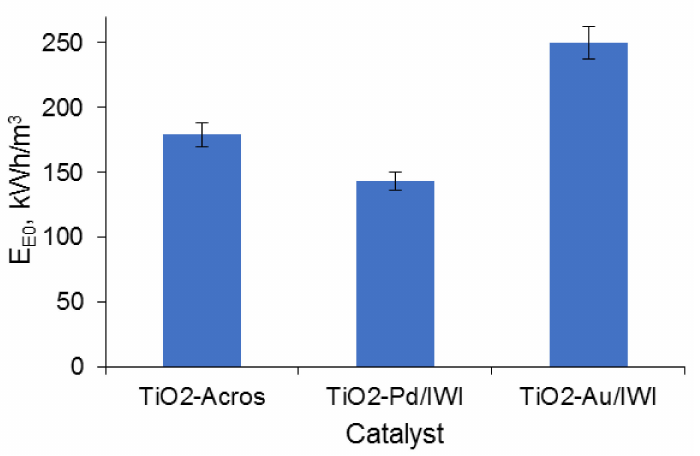
Figure 9. Energy consumption for the obtained